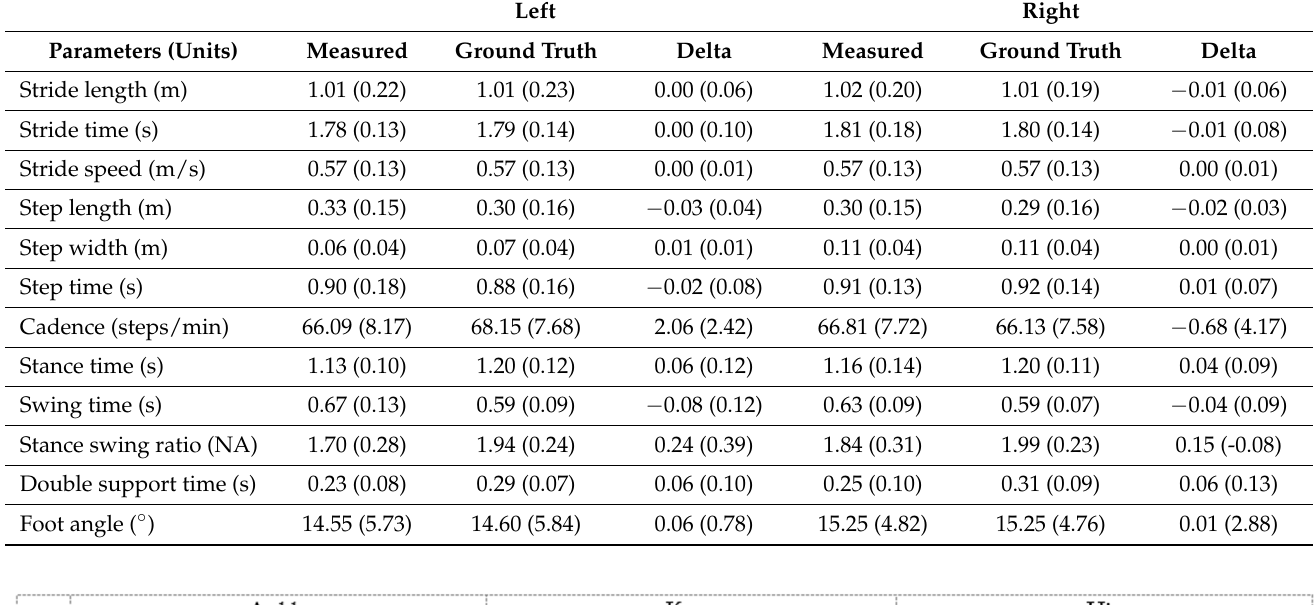
Table A11. Stride parameters for participant two: walker test (mean and standard deviation in brackets).